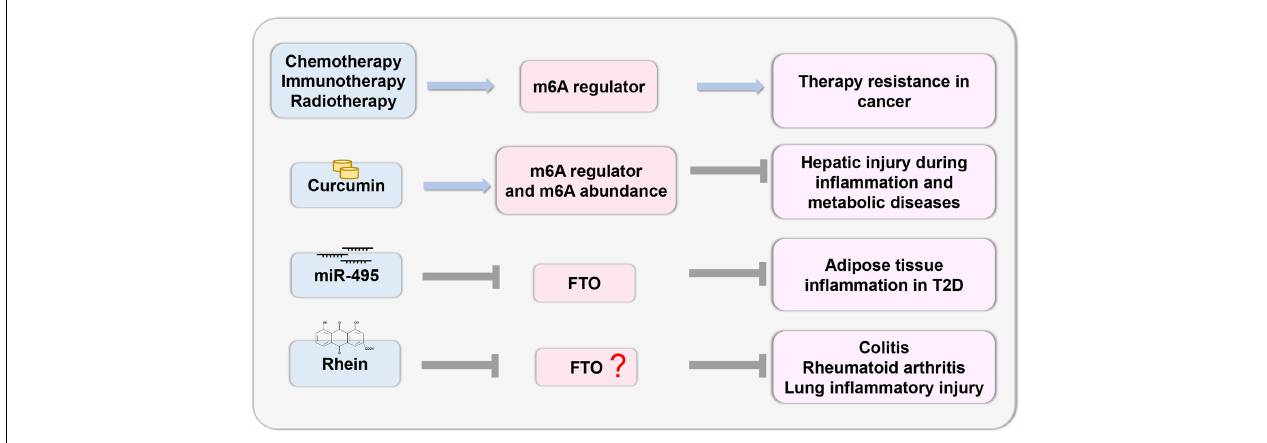
FIGURE 4 | Therapeutic potential based on m6A. The study of epigenetic changes in inflammatory response provides the possibility to develop effective drugs with specific targets based on the m6A regulator.